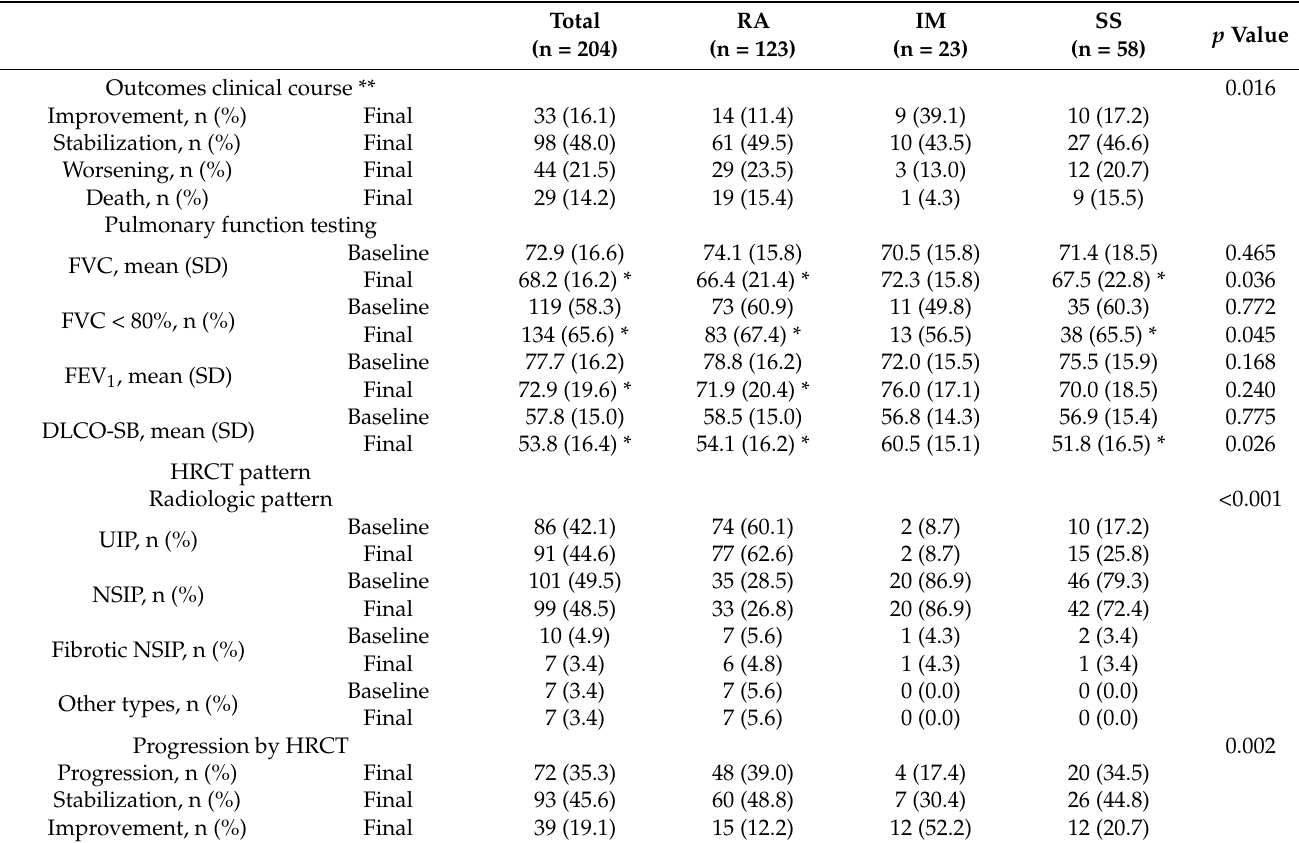
Table 3. Results of pulmonary function testing.